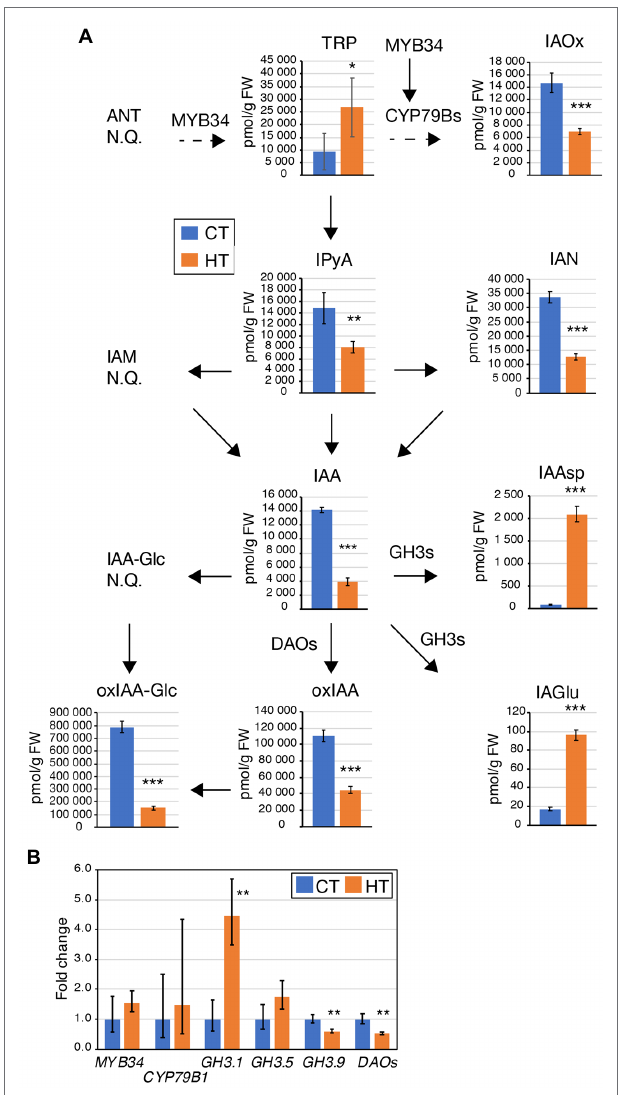
FIGURE 7 | Differences in auxin and auxin metabolites levels and enzyme expression induced at HT in Westar 26 DAP seeds. (A) Graphs displaying the levels (pmol/g FW) of tryptophan (TRP), indole-3-acetaldoxime (IAOx), indole-3- pyruvic acid (IPyA), indole-3-acetonitrile (IAN), indole-3-acetic acid (IAA), IAA- aspartate (IAAsp), IAA-glutamate (IAGlu), 2-oxoindole-3-acetic acid (oxIAA) and oxIAA-glucose (oxIAA-Glc). Anthranilate (ANT), indole-3-acetamide (IAM), IAA- glucose (IAA-Glc) were not quantified (NQ). Measurements were done in two biological replicates, five technical replicates in Westar 26 DAP seeds from plants grown at CT (blue) and HT (orange). Shown is the average ± SD of one of the two biological replicates. Asterisks indicate statistically significant difference in HT in a paired Student’s t -test ( t -test; *, **, and *** correspond to value of p 0.05 > p > 0.01, 0.01 > p > 0.001, and p < 0.001, respectively). Arrows indicate the direction of the biosynthesis pathway (plain arrow, direct reaction; dashed arrow, multiple-step enzymatic reactions). The names closed to the arrows indicate the enzymes involved in the reactions and whose gene expression was tested (B) . Source data are shown in Supplementary Table S3 . (B) Expression analysis by RT-qPCR of BnaMYB4 , BnaCYP79Bs , BnaGH3.1 , BnaGH3.5 , BnaGH3.9 , and BnaDAOs in Westar 26 DAP seeds. The graph displays the fold changes in expression between CT (blue) and HT (orange). Asterisks indicate statistically significant difference in HT in a paired Student’s t -test ( t -test; ** corresponds to value of p 0.01 > p > 0.001). Primers and LOC information are presented in Supplementary Table S1